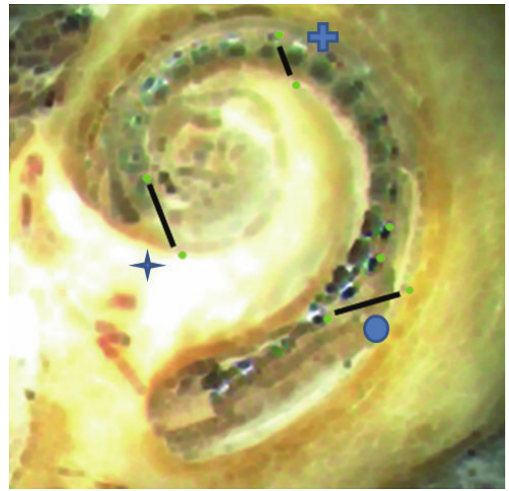
Figure 2: Digitally captured view on the scalar opened cochlear and the CI array with estimated distances. Tip distance (star), approximation distance (plus), and pullback distance